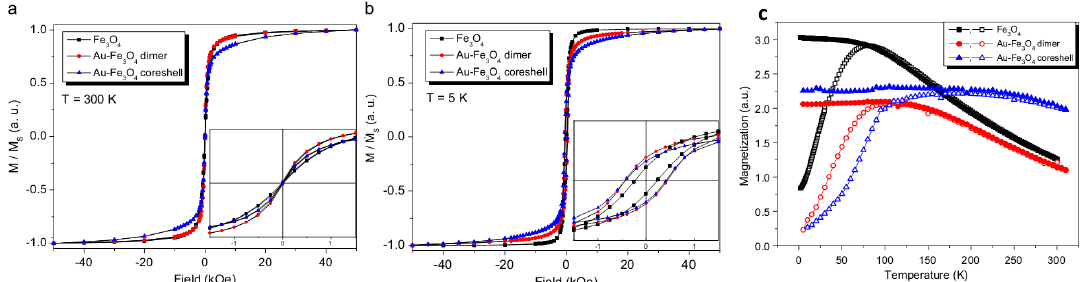
Figure 21. M/M s hysteresis loops measured at 300 K ( a ) and 5 K ( b ) on powdered Fe 3 O 4 , dimer and core-shell Au-Fe 3 O 4 NPs. ZFC (hollow symbols) and FC (solid symbols) magnetization measurements of the powder samples for an applied magnetic field H = 50 Oe ( c ). Reproduced with permission from [70]. Elsevier, 2012.